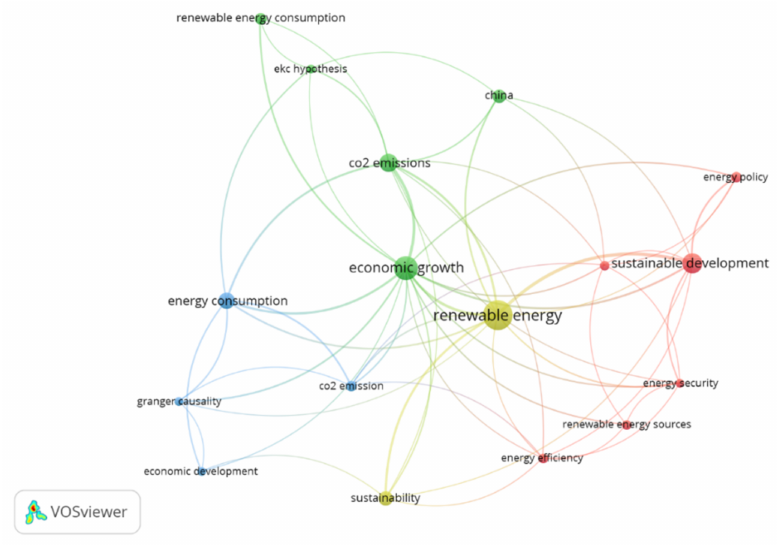
Figure 5. Keywords Occurrence